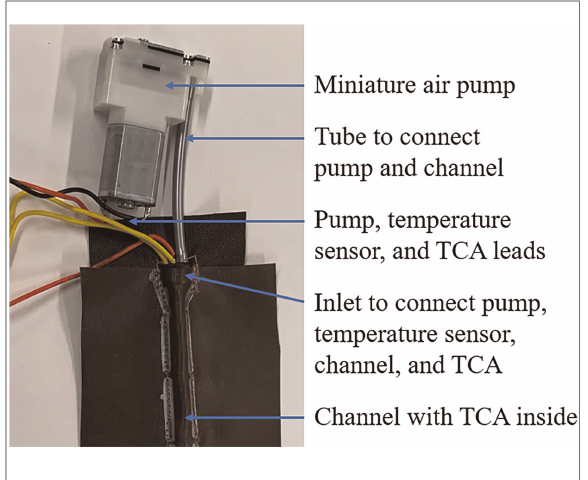
FIGURE 4 Final design of the cooling apparatus. The design consists of a fabric channel to house the TCA with a miniature air pump connected to the channel with a fl exible plastic tube.